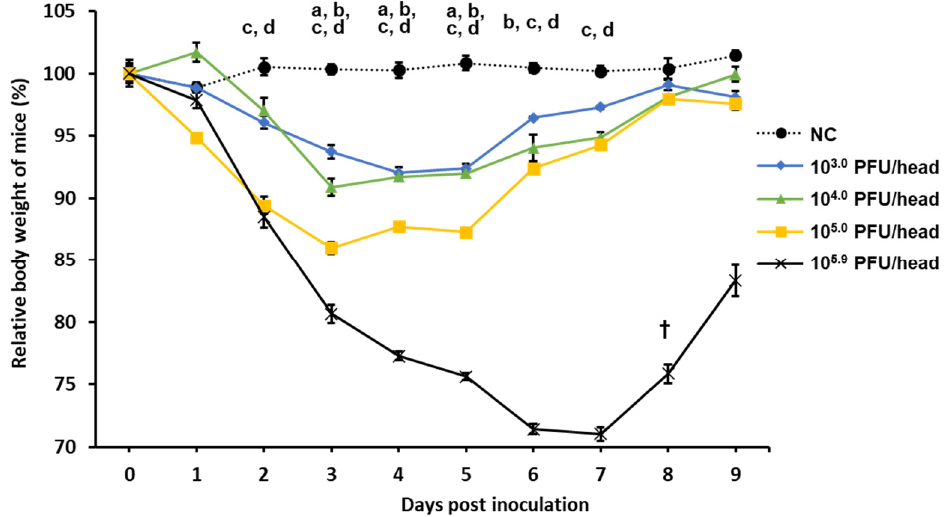
Figure 2. Antigenic cartography based on the cross-HI test of the viruses and antisera of di ff erent lineages. In antigenic cartography, vertical and horizontal axes show the distance of the antigen. Dots with round and square shapes indicate antigens and antibodies, respectively. The distance between two dots on the map represents the antigenic distance. Blue and red dots indicate the isolates belonging to the Eurasian and North American lineages, respectively. The antigenic group is shown in yellow or green. The dotted line represents homologous combination. The spacing between grid lines is equivalent to an antigenic unit distance corresponding to a two-fold HI di ff erence.